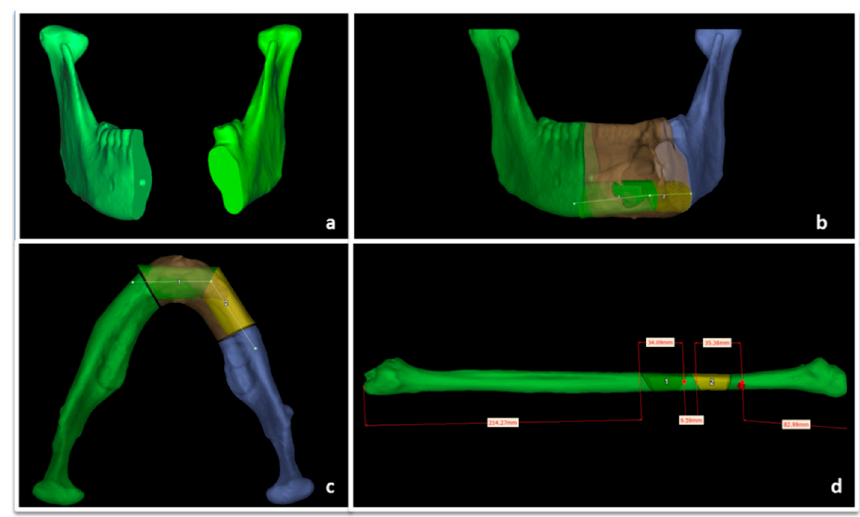
Figure 7. ProPlan CMF (Depuy Synthes, Solothurn, Switzerland, and Materialise, Leuven, Belgium) preoperative surgical planning of mandibular resection vascularized fibular flap reconstruction. ( a ) Mandibular defect; ( b ) mandibular reconstruction planning, coronal view; ( c ) mandibular reconstruction planning, axial view; ( d ) fibular segmentation planning.